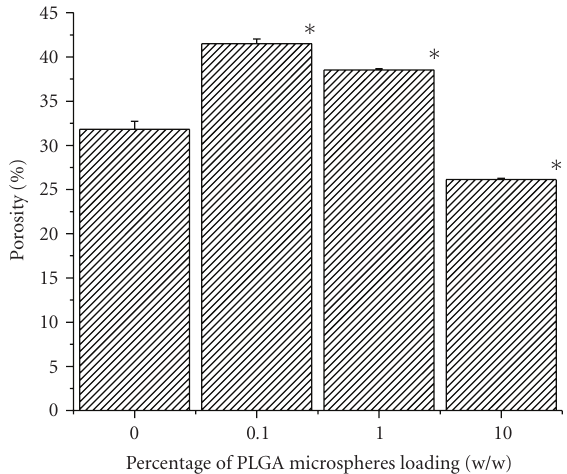
Figure 7: E ff ect of PLGA microsphere incorporation on percentage elongation at break of gelatin sca ff old. Values are mean ± S.D. ( n = 3). ∗ P < . 05, compared to gelatin sca ff old having no PLGA